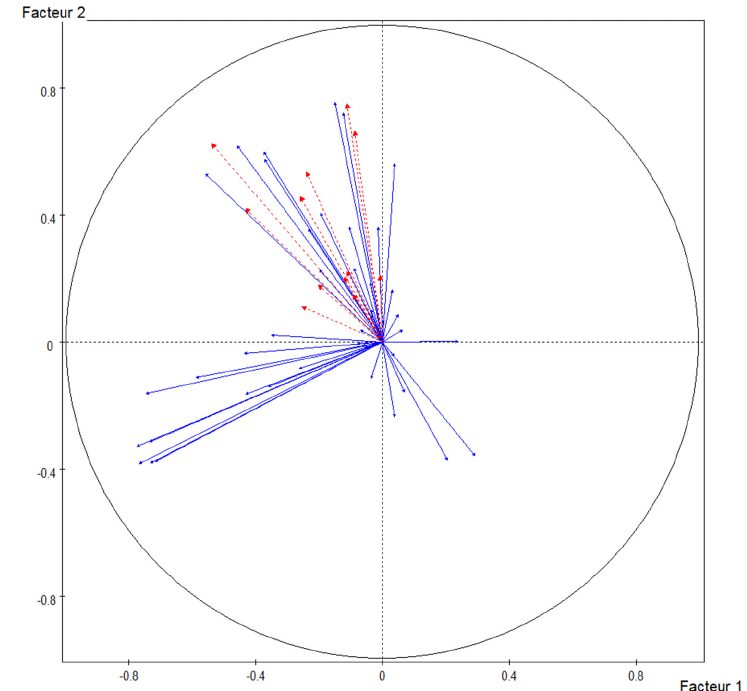
Figure 4. Biplot of PCA in the central district.